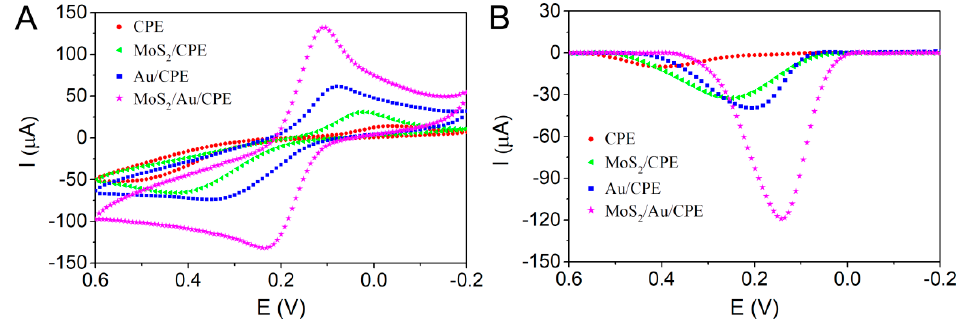
Figure 3. The cyclic voltammetry (CV) ( A ) and differential pulse voltammetry (DPV) ( B ) curves recorded at bare CPE, MoS 2 /CPE, Au/CPE, and MoS 2 /Au/CPE in 0.1M PBS solution (pH 7.0) containing 1.0 mM DA.